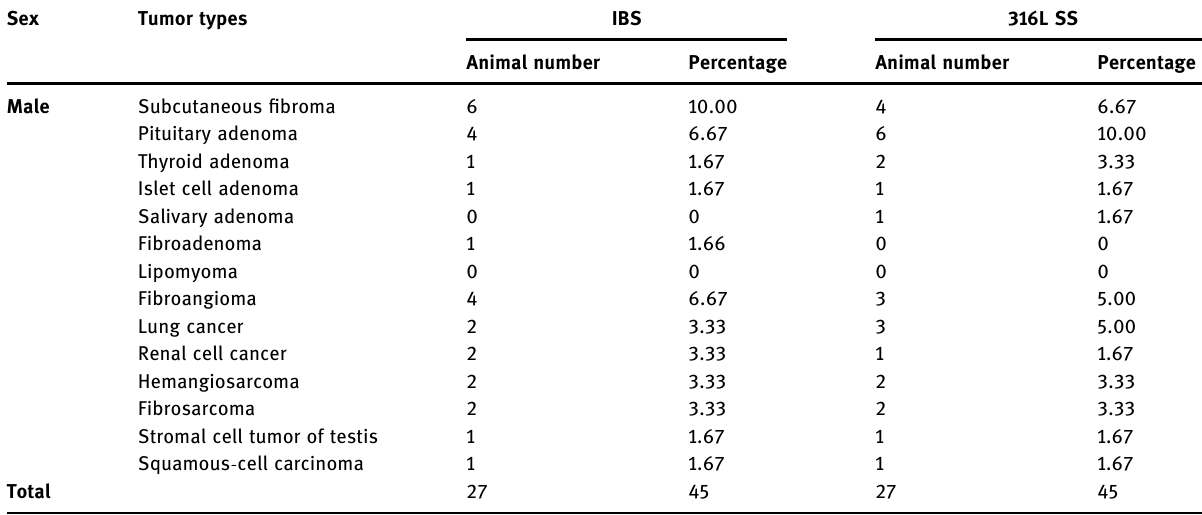
Table 5: Summary of tumor types and numbers ( male )